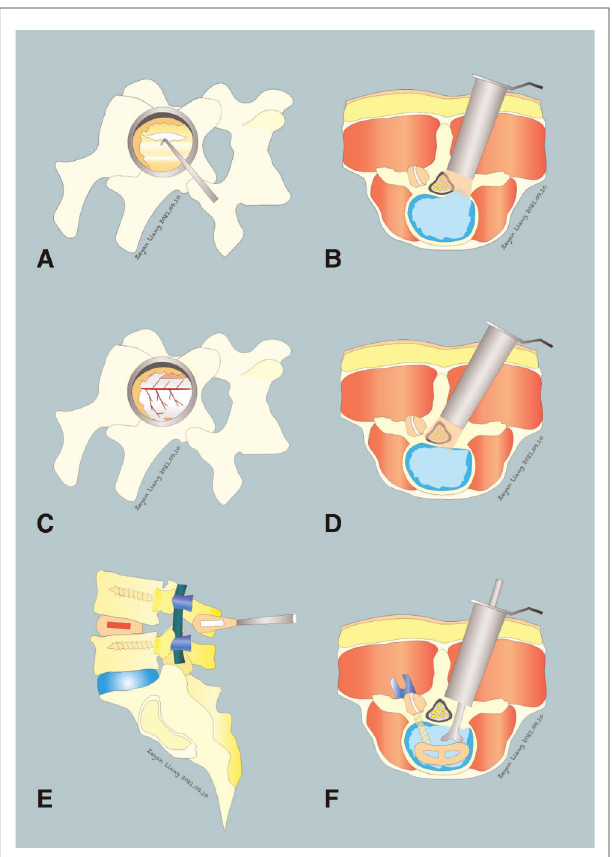
FIGURE 1 | Comparison of PMTD and MIS TLIF Techniques. PMTD: ( A ) insertion of a nerve hook to start dissection of the ligamentum fl avum (LF). ( B ) completing the ipsilateral decompression. ( C,D ) a complete removal of the LF is achieved and the dura is safely exposed. The contralateral exiting and traversing nerve roots may also be exposed if necessary. MIS TLIF: ( E,F ) an L4 – 5 MIS TLIF, a surgical option that includes a fusion procedure in addition to